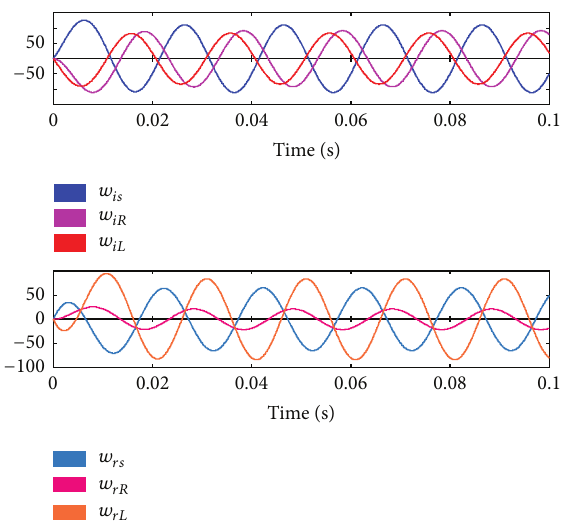
Figure 10: Scattering wave’s responses of the VRL